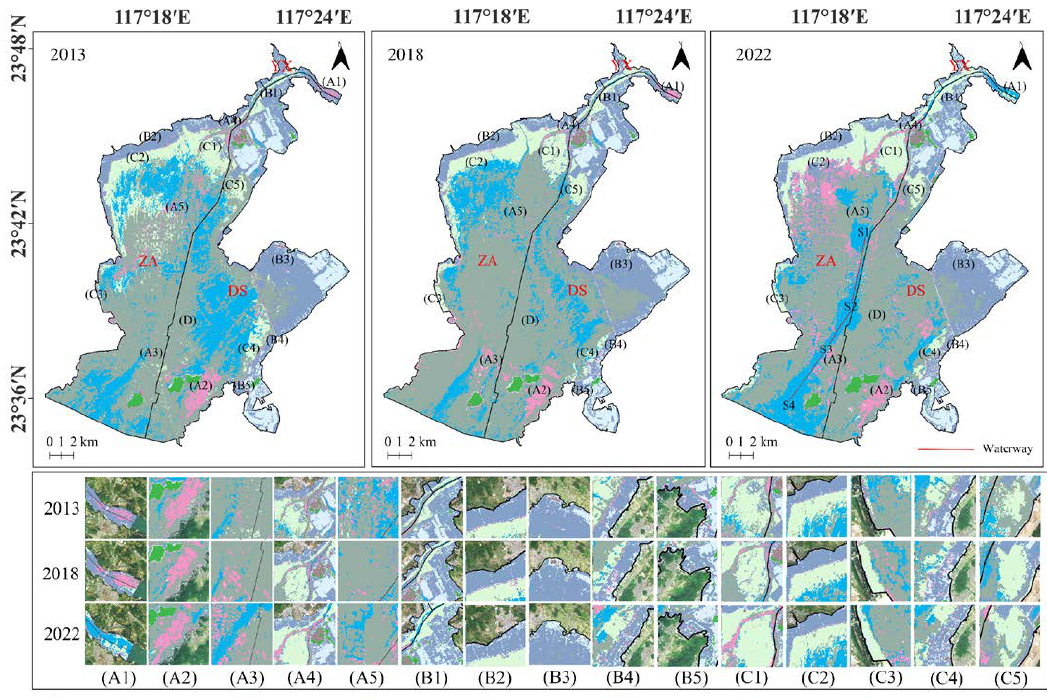
Figure 4. Maps showing results from the interpretation of remote sensing data for the study area for 2013, 2018, and 2022. The cage is represented by letters A1 to A5, whereas the pond is denoted by letters B1 to B5, the mudflat by letters C1 to C5 and the raft by letters D. The waterway is shown by the line from S1 to S4 on the 2022 map that was derived from remote sensing data.